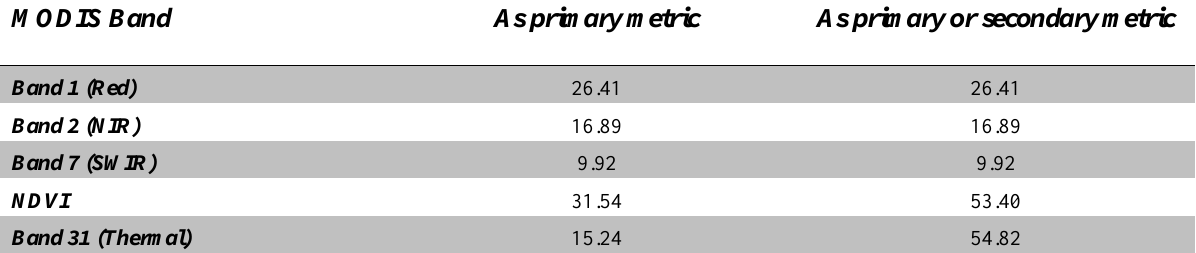
Table 3. Percent explained deviance by input MODIS band and